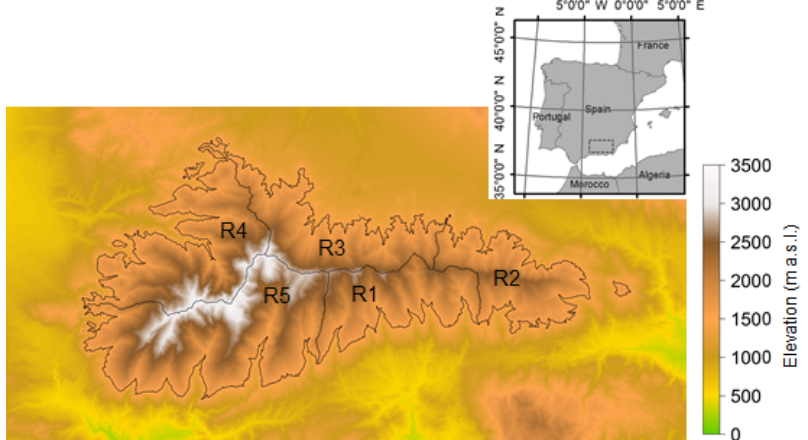
Figure 1. Area of Sierra Nevada Mountain (Spain) above 1500ma.s.l. and limits of the five regions in which the study area has been divided for the spatial analysis: R1 – Adra, R2 – Andarax, R3 – Fardes, R4 – Genil and R5 – Guadalfeo.